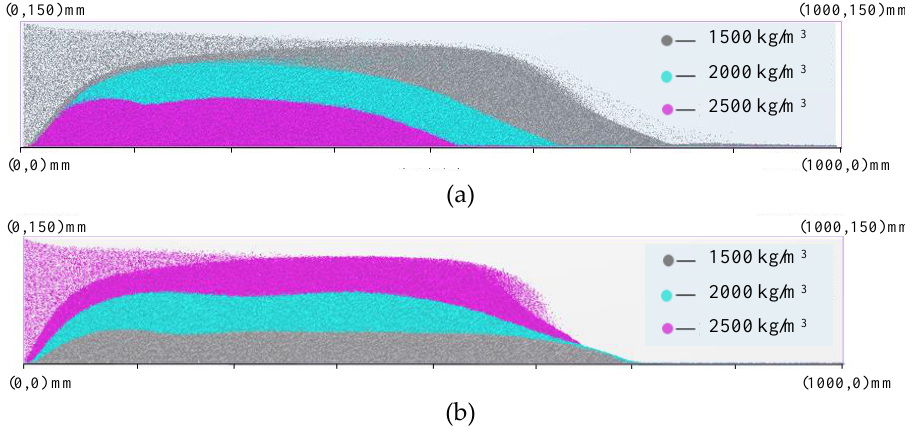
Figure 9. Proppant placement under different pumping sequences: ( a ) pumping high-density proppant first and then low-density proppant; ( b ) pumping low-density proppant first and then high-density proppant.